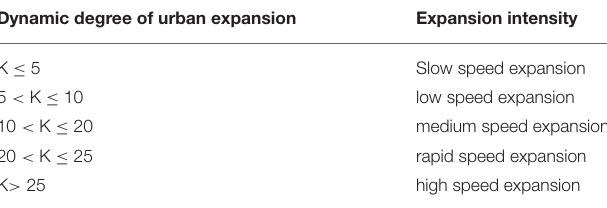
TABLE 2 | Classification of urban expansion according to Dynamic degree of urban